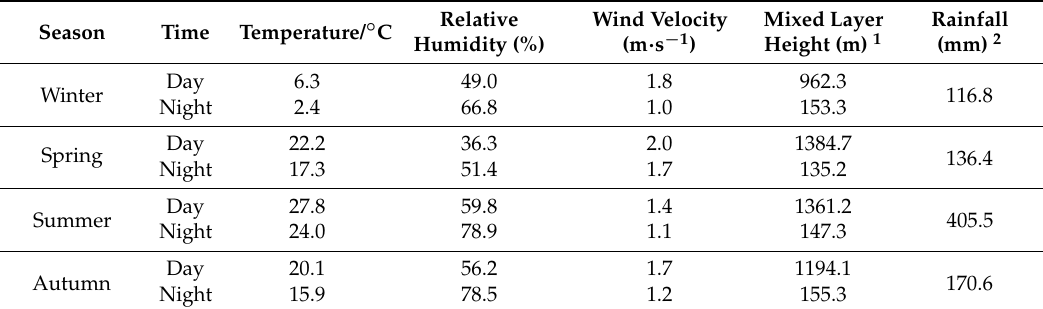
Table 2. Mean daytime and nighttime meteorological parameters in four seasons.